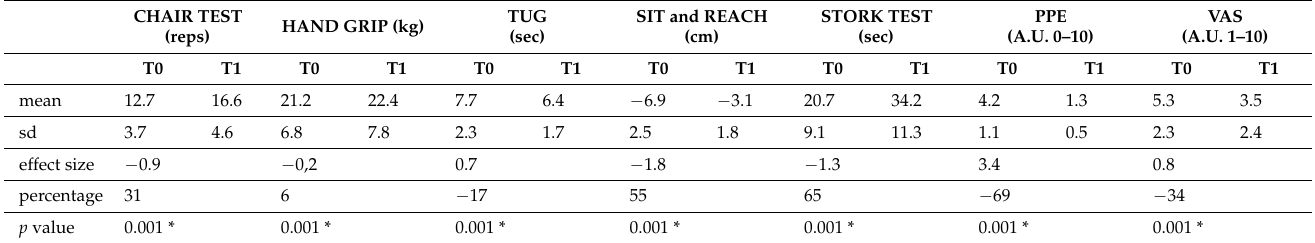
Table 3. Average values, standard deviation (sd), effect size and significance value ( p value) of the measured data before starting the training period (T0) and at the end of the training period (T1). Percentage is the percentage change in T0 value. * = statistically